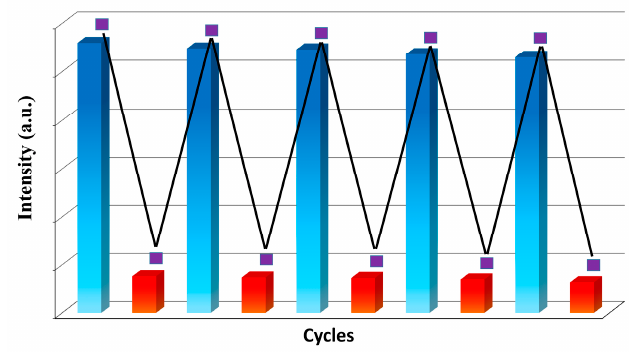
Figure 5. The quenching and recyclability test of TbL 2 upon addition of 200 μ M acetone in methanol solution. The luminescence was recovered by centrifuging the dispersed crystals in methanol after sensing and washing several times with methanol.